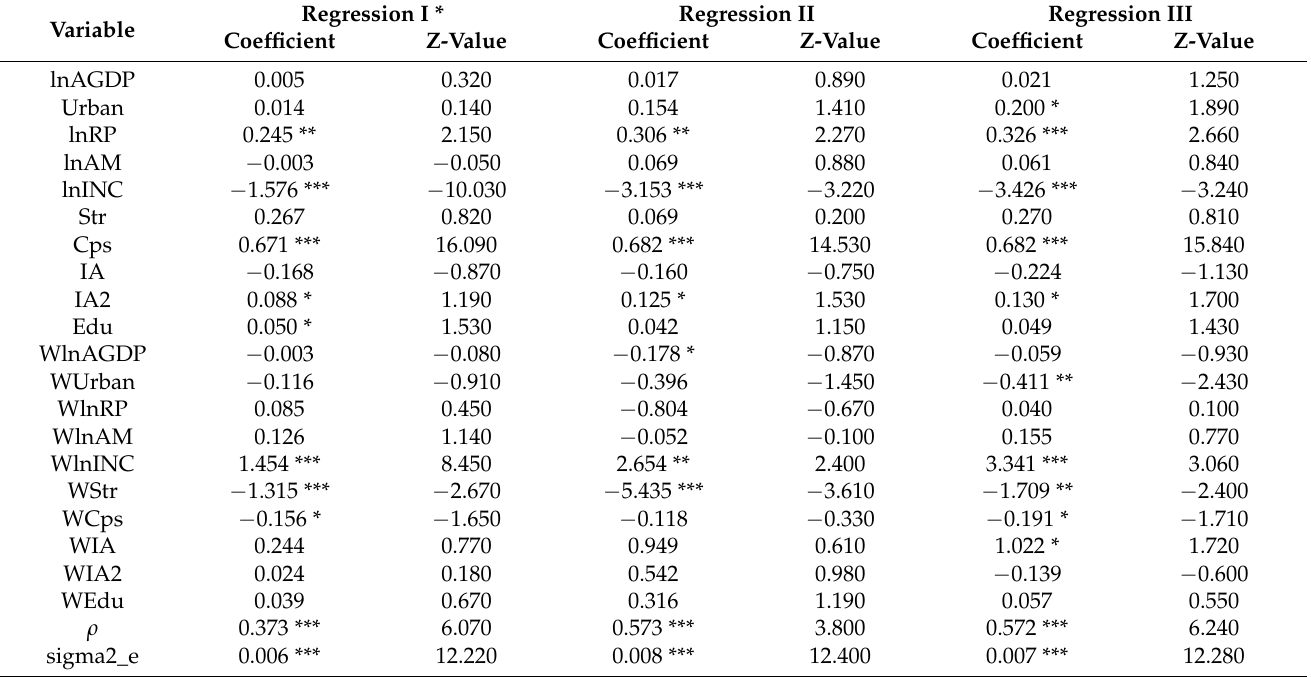
Table 8. Spatial measurement estimation results of the impacts of the variables on the ACESs under different spatial matrices.